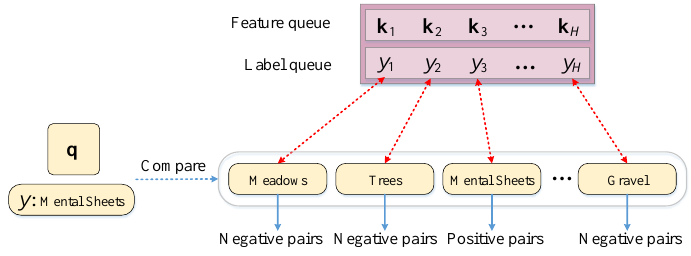
Figure 4. The generation process of pairs in SCL.